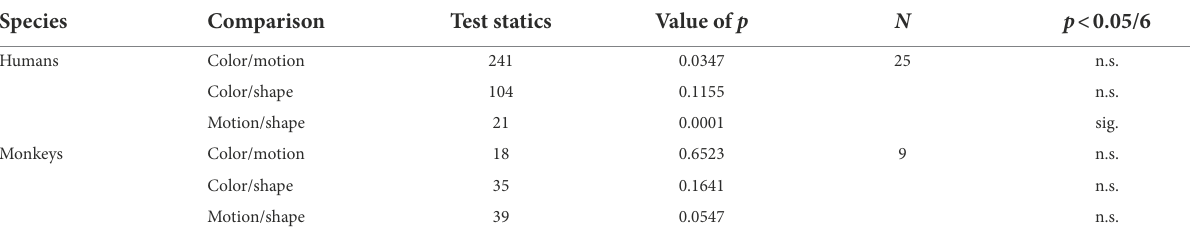
TABLE 1 Overview of the results of the Wilcoxon paired, two-sided, signed rank test on CFI differences across rule types (color, motion, and shape) for humans and monkeys separately (Figure 5B). Species Comparison Test statics Value of p N p < 0.05/6